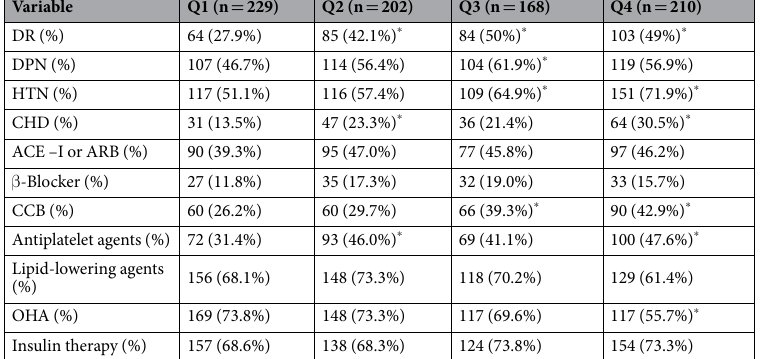
Table 3. Complications and medications of Q1 to Q4 in T2D patients. Notes: * P value of χ 2 test < 0.05 compared to Q1 group. Abbreviation : DR, diabetic retinopathy; DPN, diabetic peripheral neuropathy; HTN, hypertension; CHD, coronary heart disease; ACE-I or ARB, use of an angiotensin-converting enzyme inhibitor